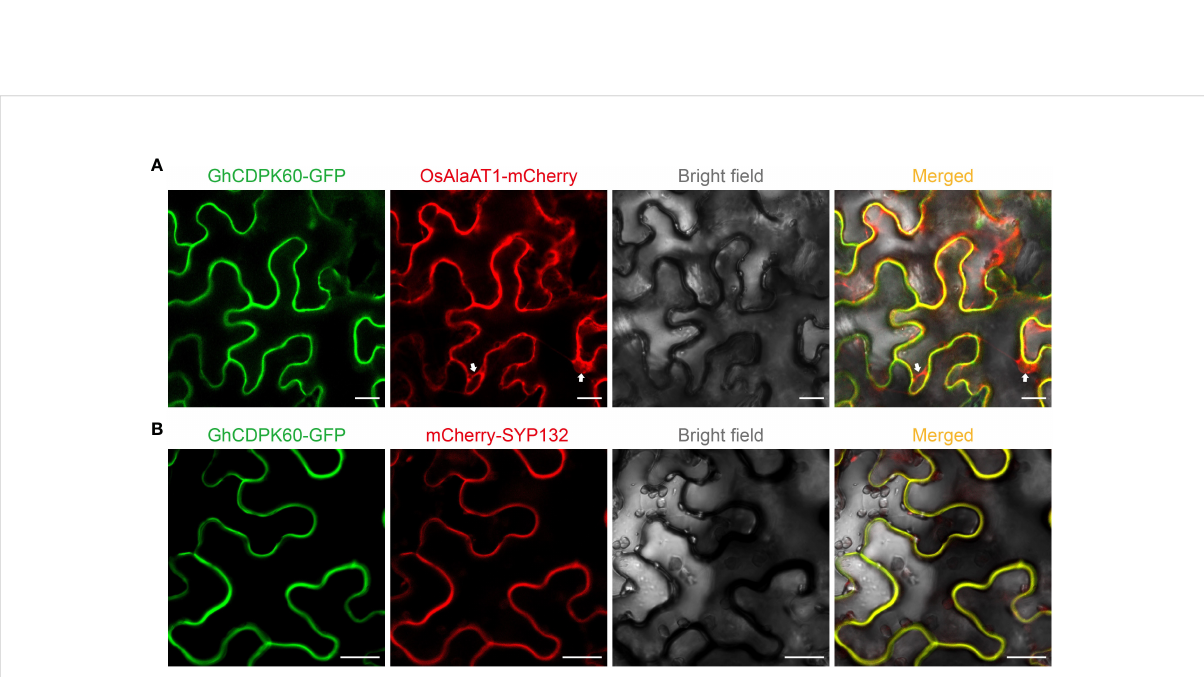
FIGURE 3 Subcellular localization of GhCDPK60. GhCDPK60 were transiently co-expressed with different marker, OsAlaAT1 (A) or SYP132 (B) , in N. benthamiana leaf cells to determine its subcellular localization. White allows indicate the signals of cytoplasm component. Bars = 20 µm.